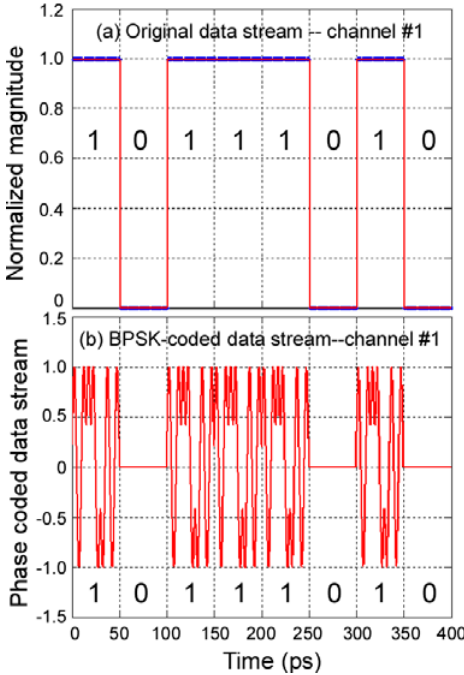
Figure 4. ( a ) original data symbol 1 0 1 1 1 0 1 0 of channel #1. The signal bits are in non-return-to-zero (NRZ) format. Each bit of the signal is 50 ps; ( b ) phase-coded (BPSK) data stream of channel #1 using its phase code [0 π 0 0 0 π π 0 π 0].